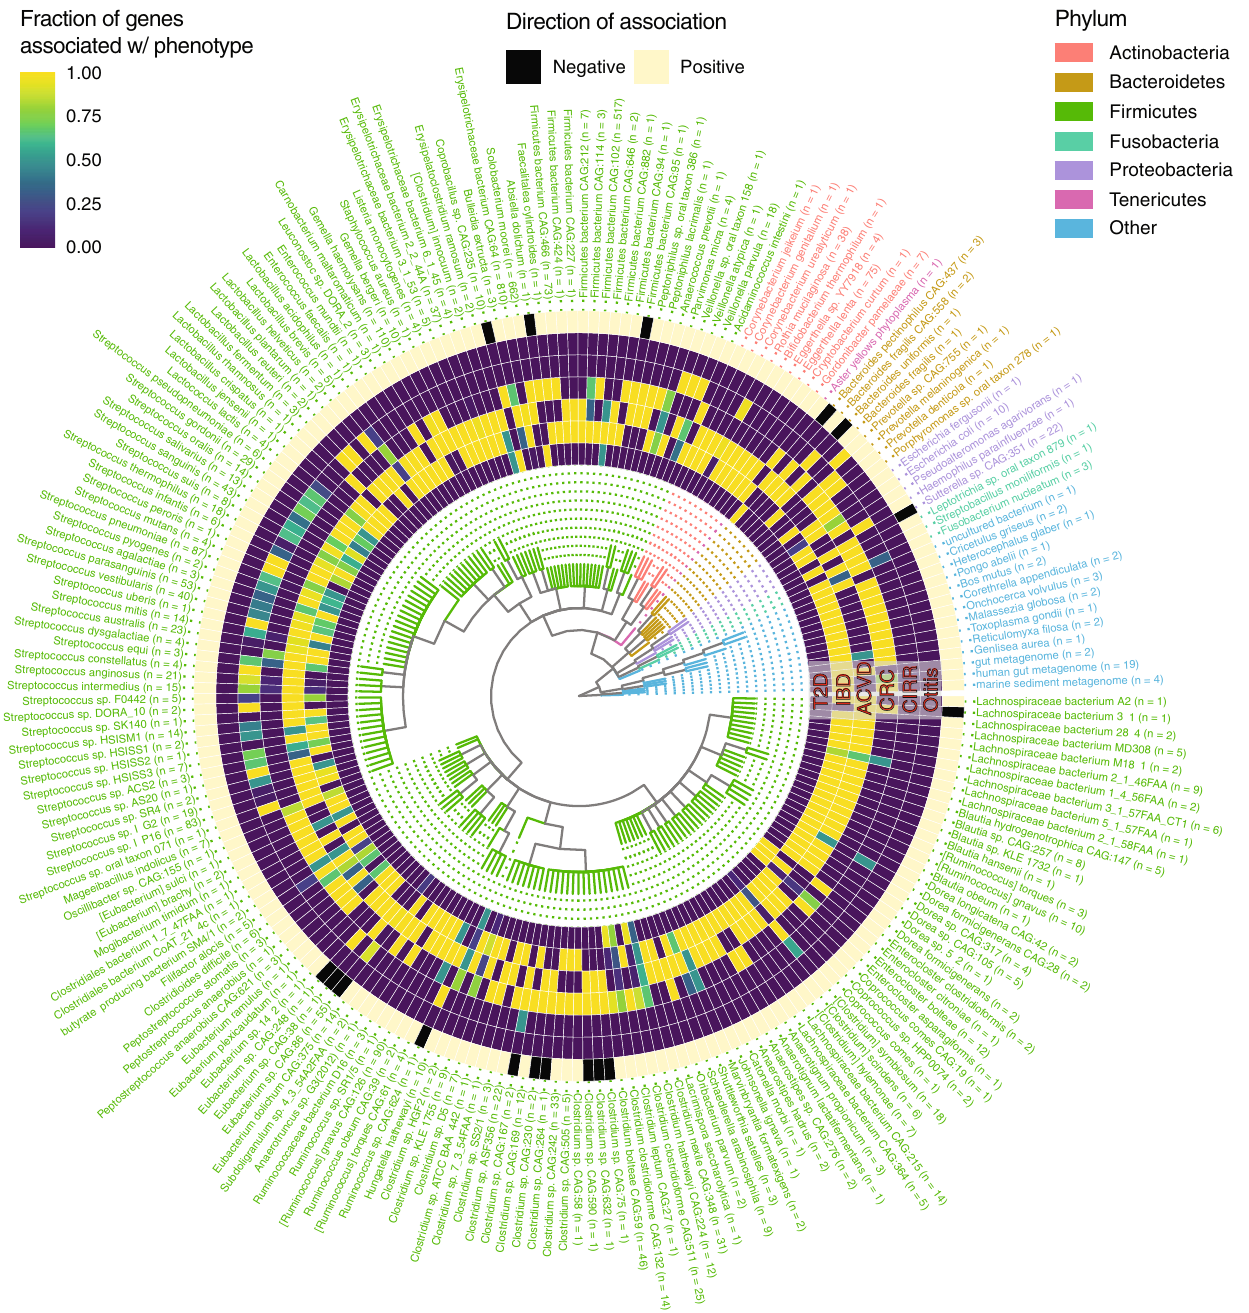
Fig. 5 Cross-disease, gene-level architectures. The taxonomic distribution of genes associated with at least two phenotypes, excluding adenoma due to a lack of signi fi cant, robust, and overlapping associations. Heatmap color for the inner six rings corresponds, for a particular phenotype, the fraction (of the N in the axis labels) of genes associated with a given taxonomic annotation. Lighter colors indicate a value closer to 1. Outer ring corresponds to if an association was negative (black) or positive (beige) across all phenotypes. Text color corresponds to phylum, with nonbacterial phyla listed as “ Other ”